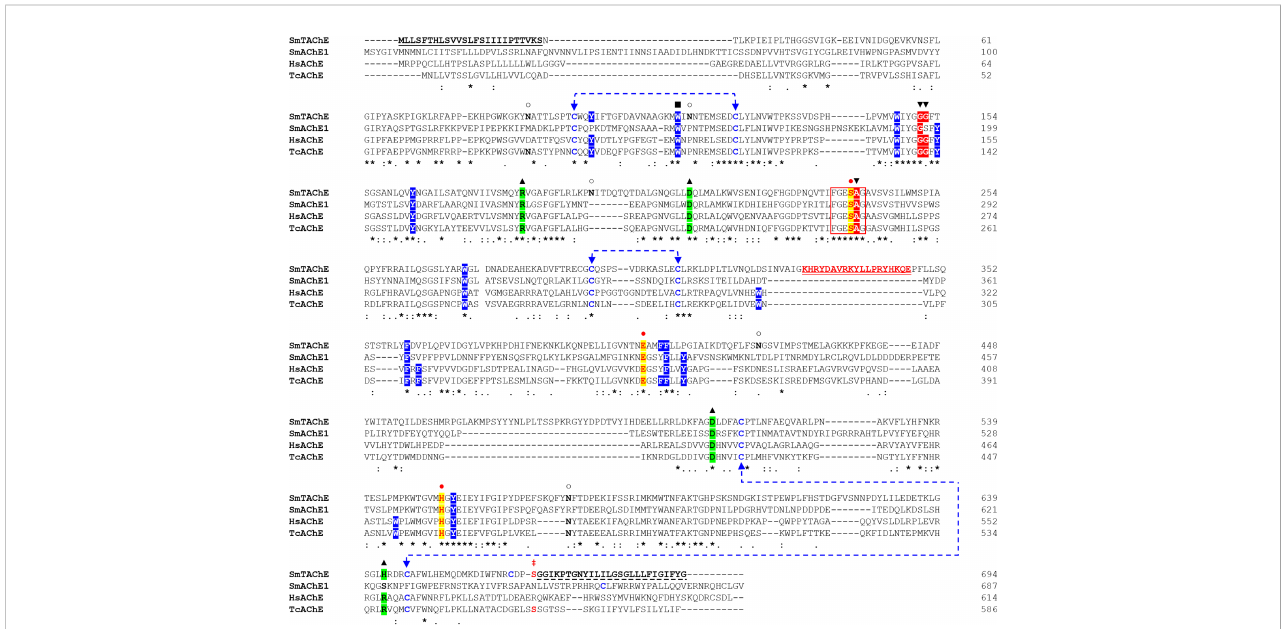
FIGURE 4 Alignment of the amino acid sequences of selected AChE proteins. The amino acid sequence of SmTAChE (Accession number OP018961), SmAChE1 (AAQ14321.1), human AChE (HsAChE, GPI-modi fi ed H form; NP_000656) and the Electric eel, Torpedo californica (TcAChE ; GPI-modi fi ed form, P04058.2) were aligned using Clustal W. The catalytic triad residues (S 239 , E 401 , H 553 , where amino acid positions correspond to the numbering of the SmTAChE sequence) are in red and indicated with and shaded in yellow. The 6 amino acid signature sequence ( 236 FGESAG 241 ) of cholinesterases around the active serine residue (S 239 ) is boxed. The choline-binding site (W 115 ) is indicated with ▪ . The three intrachain disul fi de bonds formed using six conserved cysteines (C 97 -C 125 , C 293 -C 306 , C 514 -C 647 ) are indicated with dashed blue lines. The four conserved charged residues involved in forming two salt-bridges are marked with ▴ and shaded in green. The positions of the 14 aromatic residues that line the catalytic gorge in T. californica AChE are shaded in blue (9 are identical in SmTAChE). The oxyanion hole residues are indicated with ▾ and shaded in red. Five potential N-glycosylation sites (with the consensus sequence NXS/T) are marked with ○ . The amino acid sequence of the unique peptide (K 329 -E 346 ) used to generate antibodies for SmTAChE is in red and double underlined. The signal peptide of SmTAChE (M 1 -S 25 ) is underlined. The GPI anchor sequence of SmTAChE (G 669 - G 694 ) is indicated with a dashed underline, and the omega ( w )-residue (S 668 ) is indicated with . Identical residues in all sequences are marked with an asterisk (*); strongly similar residues (conserved substitution) are indicated with a colon (): weakly similar residues (semi-conserved) indicated with a dot (.), and gaps, introduced to allow maximum alignment, are marked with dashes ( – ). The numbers (right) tally the amino acid count per line for each